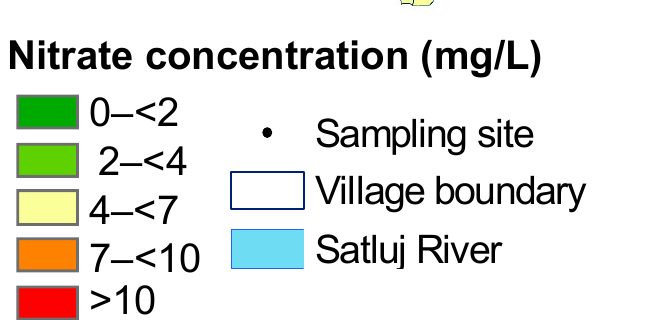
Figure 3. Spatial variability maps of nitrate concentration in groundwater (mg/L) during 2004–2005 wheat season ( a ) Nov-10, ( b ) Dec-31, ( c ) Jan-31, ( d ) Feb-28, and ( e ) Apr-10.